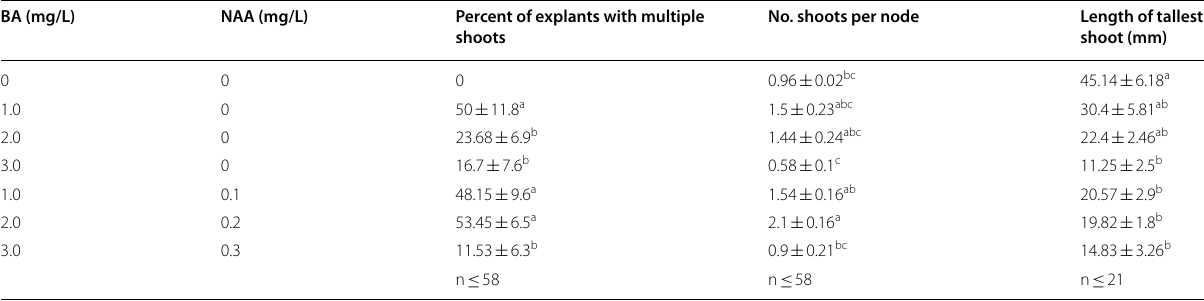
Values are means SE after 4 weeks on media. Means followed by the same letter in a column indicate no significant difference by Tukey’s multiple comparison test or ± pairwise Fisher’s exact test (P < 0.05)